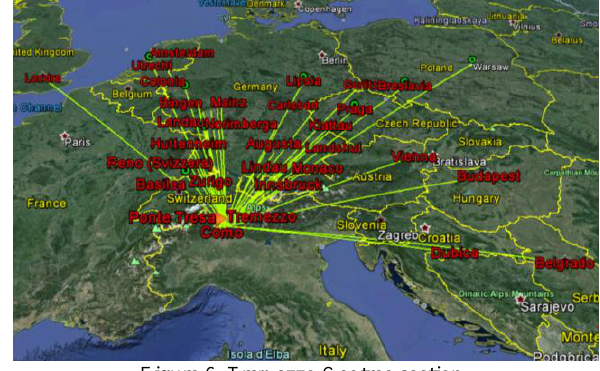
Figure 6. Tremezzo Geotree